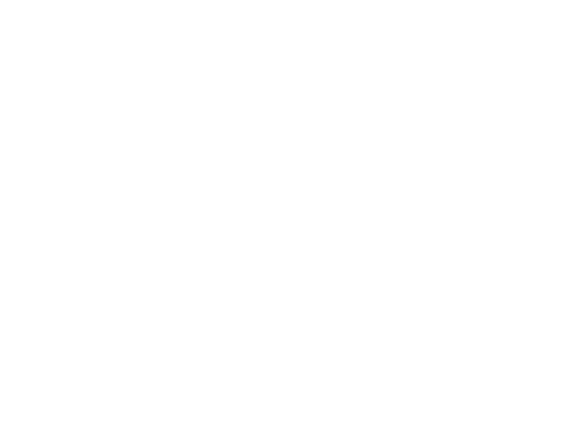
Figure 3. Comparison of the absolute difference of normalized SRE area from 100 nucleotides before and after each deep intronic variant compiled from the literature. Absolute values of normalized SRE area difference from 100 nucleotides upstream and downstream of each variant were used to compare those spliceogenic with those without any effect. Splicing variants (SPL altering) showed higher differences between previous and posterior sequences ( t -test, ** p -value ≤ 0.01). Mean ± standard deviation is represented.